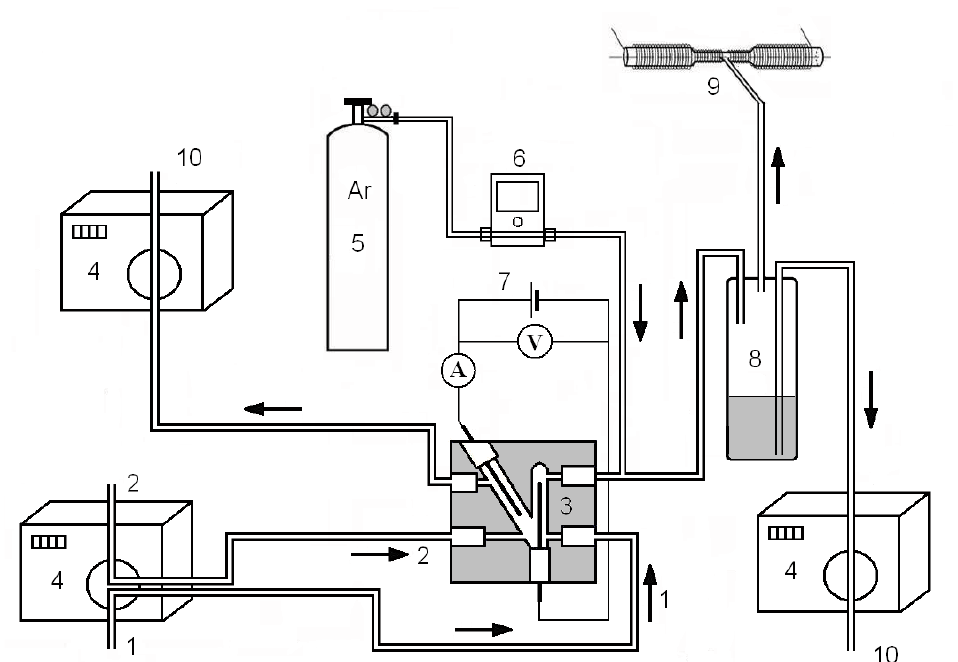
Figure 2. Instrumental setup for EcHG-QFAAS with cell E : 1 – catholyte, 2 – anolyte, 3 – flow-through electrolyte cell (type E), 4 – peristaltic pump, 5 – carrier gas, 6 – mass flow controller, 7 – electric current supply, 8 – gas-liquid separator, 9 – quartz tube atomizer, 10 - waste